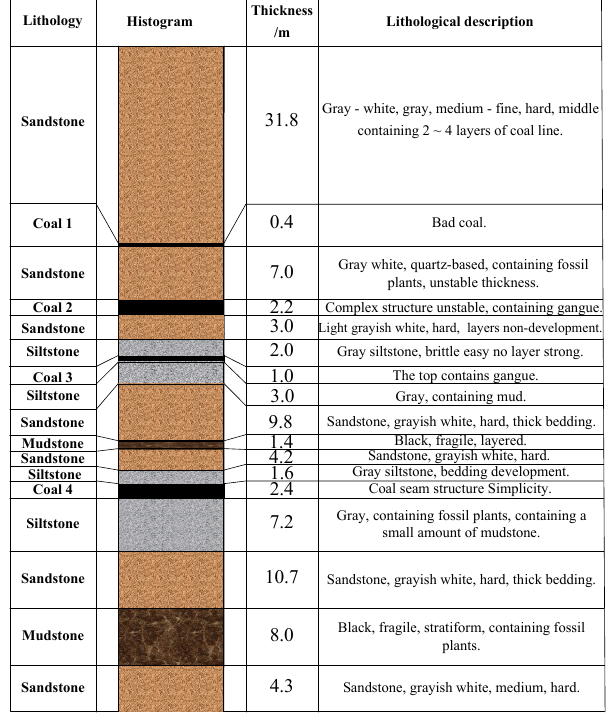
Figure 1. 2424 Coal working face rock histogram. The average thickness of the coal seam was 2.4 m, and the dip angle was 26.5 ◦ . The direct top was siltstone and sandstone, thickness was about 5.8 m, bedding development was relatively hard, and compressive strength was 21.2 MPa. The basic roof was mainly sandstone with about 11.2 m thick and hard bedding. The buried depth of the lower roadway in the 2424 coal working face was 1254 m, and the total length was 1132 m. The section was trapezoidal, and the net width was 4 m. The height of the left side was 3 m, and the height of the right side was 4 m. The roof was an arc section, as shown in Figure 2.